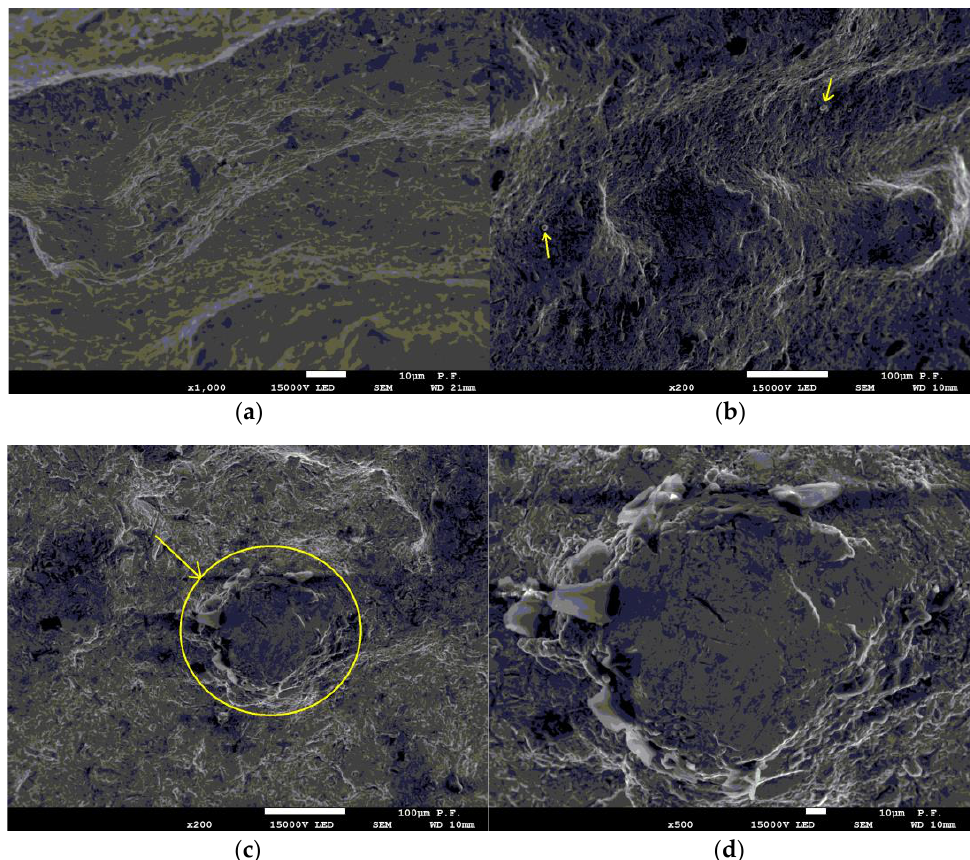
Figure 5. The microstructure of an example test sample: ( a ) surface view, ( b ) minor impurities, ( c ) agglomerated powder grains ×200, ( d ) agglomerated powder grains ×500.